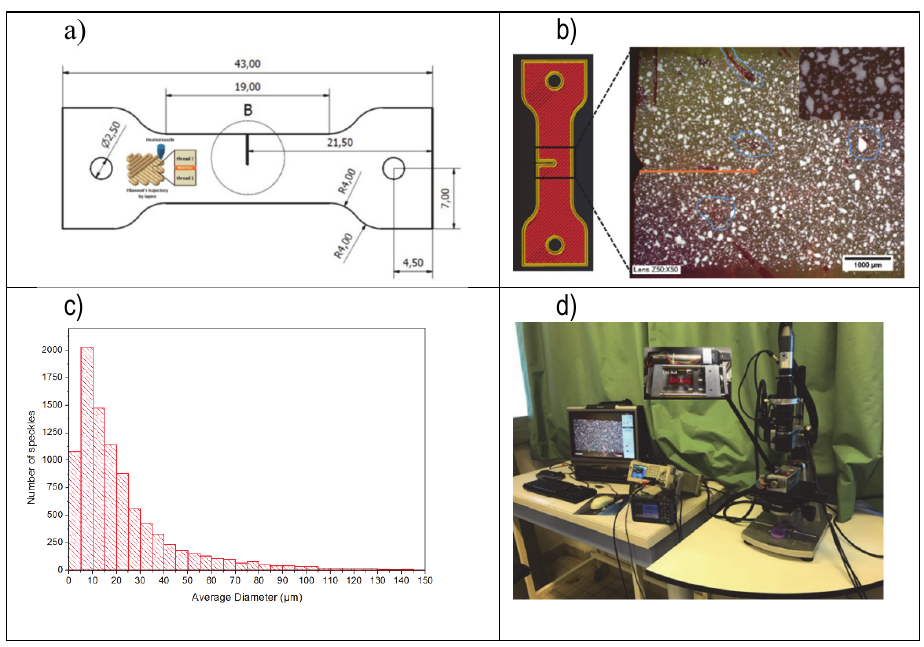
Figure 1: a) Plan of the sample used in the study. It consists to SENT specimen with a notch set as 𝑎 (cid:2868) 𝑤⁄ (cid:3404) 0.45. b) The sample is 3D printed layer by layer and oriented +45°/-45°. After surface preparation of the sample, the micro-speckle pattern is deposited. c) Histogram shows the diameter distribution of speckles at the sample surface. More than 70% of speckles have their diameter less than 20 µm. d) The experimental set up consist in a digital microscope for the surface observation, a tensile micromachine and trigger